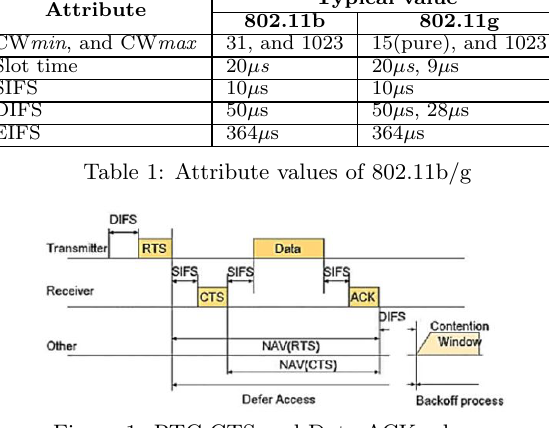
Figure 1: RTC-CTS and Data-ACK scheme.